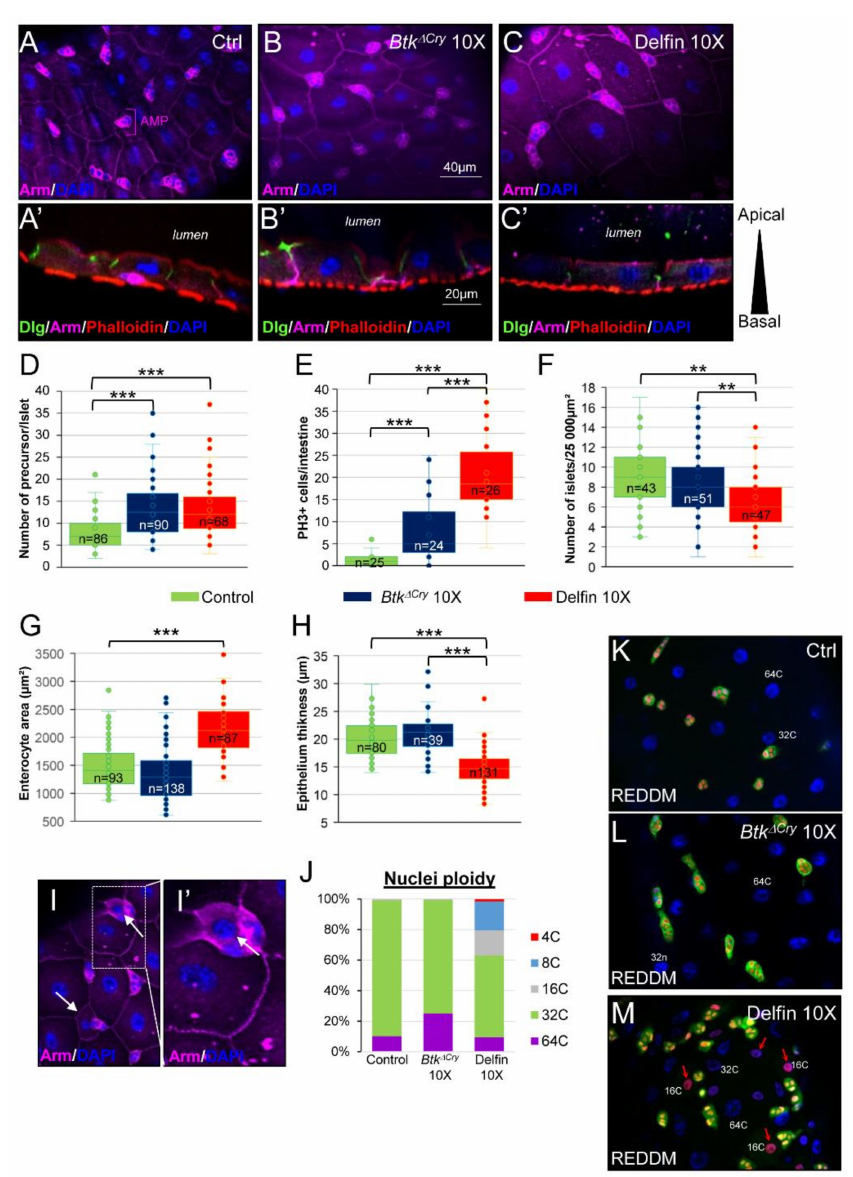
Figure 7. Larval midgut regeneration upon aggression. ( A – C’ ) Immunolabelling of Dlg::GFP L3 midgut from larvae raised on control medium ( A , A’ ), on medium contaminated with Btk ∆ Cry 10X ( B , B’